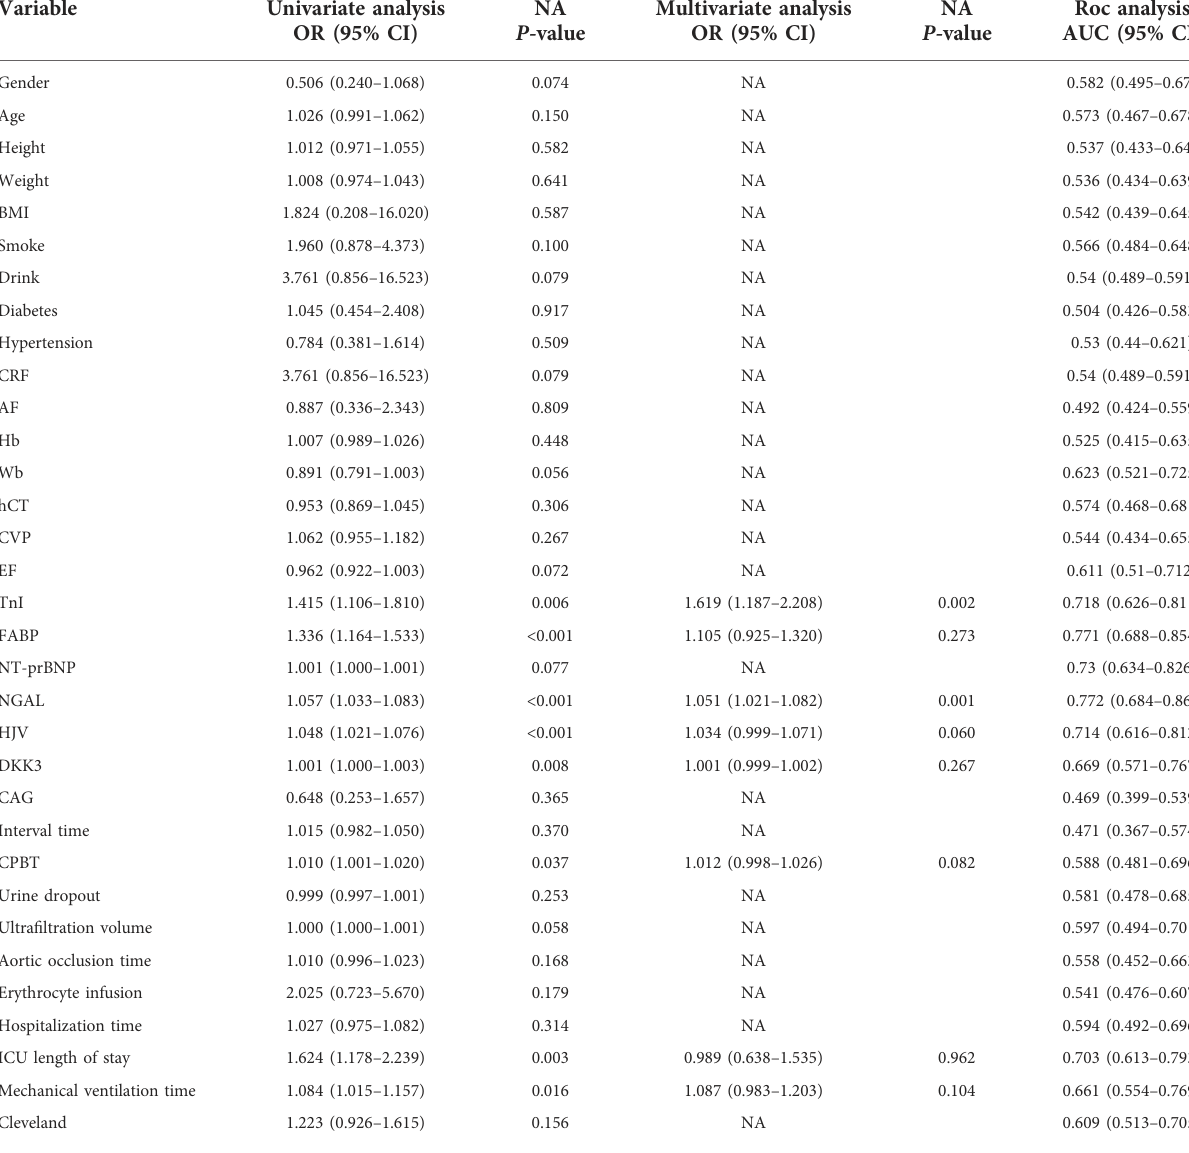
TABLE 2 Univariate, multivariate logistic regression and ROC